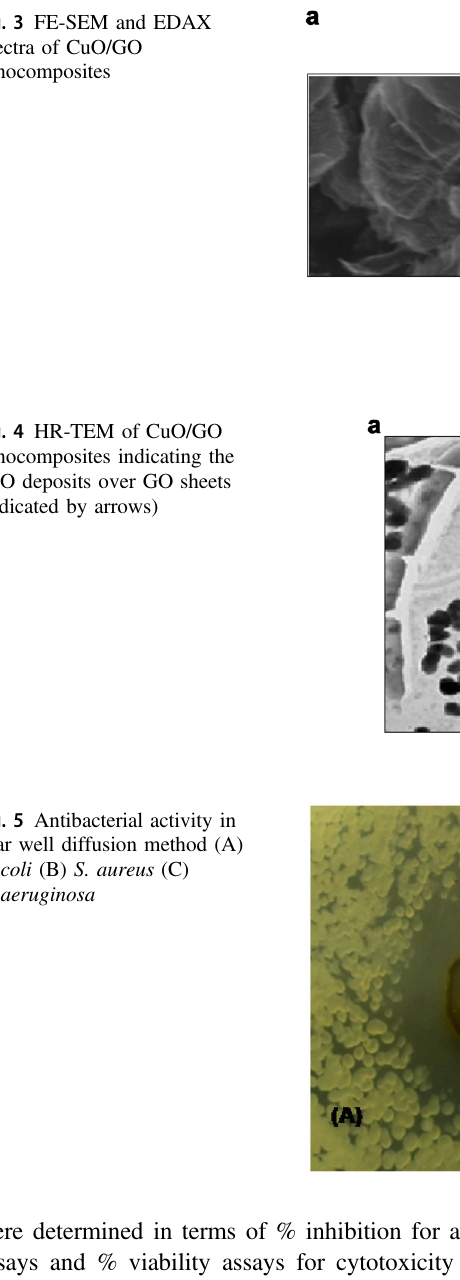
Fig. 3 FE-SEM and EDAX spectra of CuO/GO nanocomposites